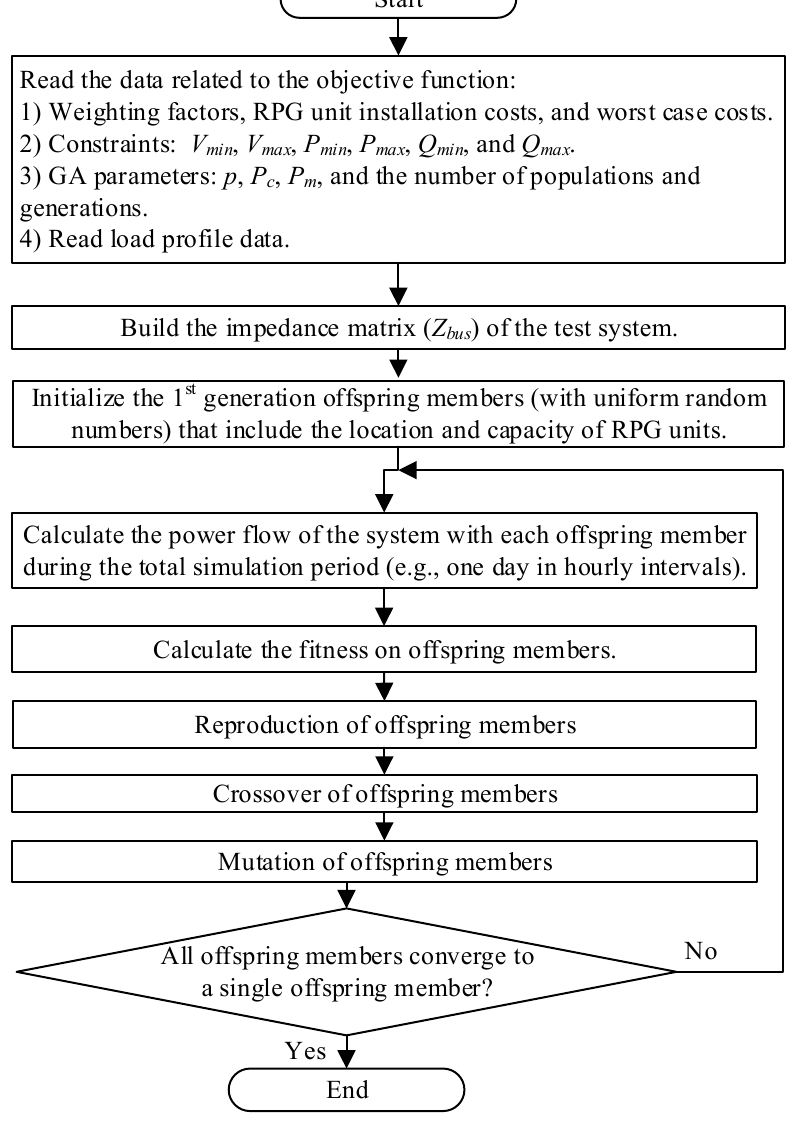
Figure 8. Workflow of the proposed method.